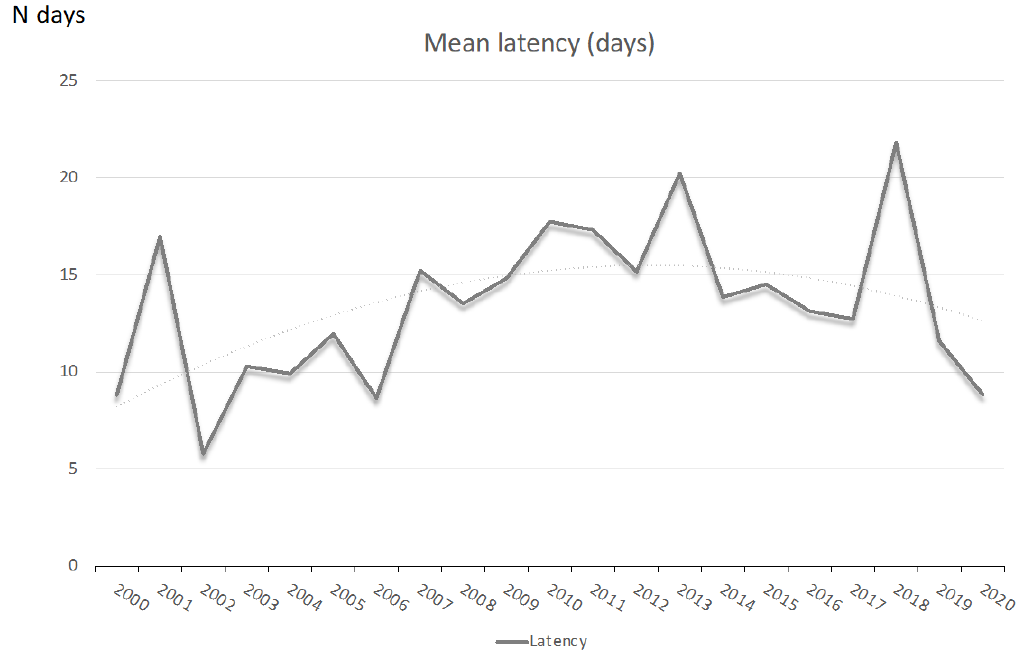
Figure 4. Temporal trend for latency period between PPROM and delivery.